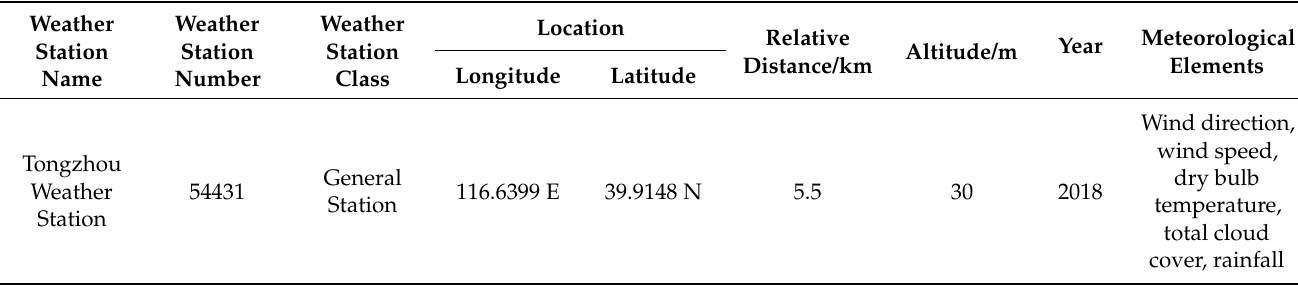
Table 1. Basic information of ground meteorological observation